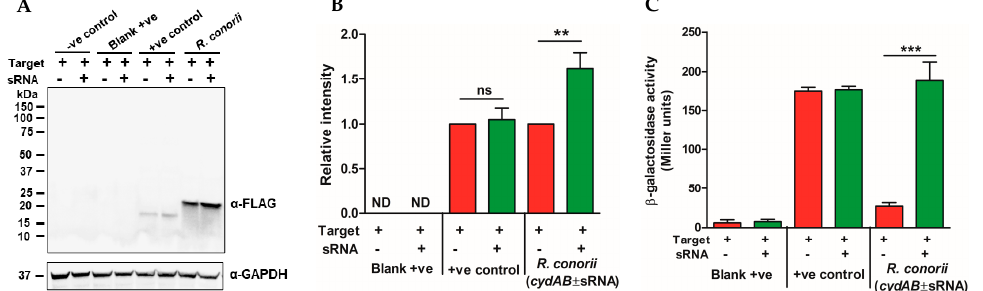
Figure 4. R. conorii sRNA Rc _sR42 is required for transcript stabilization and expression of cydA . The plasmid construct carrying the translational fusion of the seed region of cydAB mRNA was expressed in the presence/absence of Rc _sR42. The expression of FLAG-LacZ- cydA was measured via Western blotting and β -galactosidase assay. ( A ) Western blot image showing the expression of